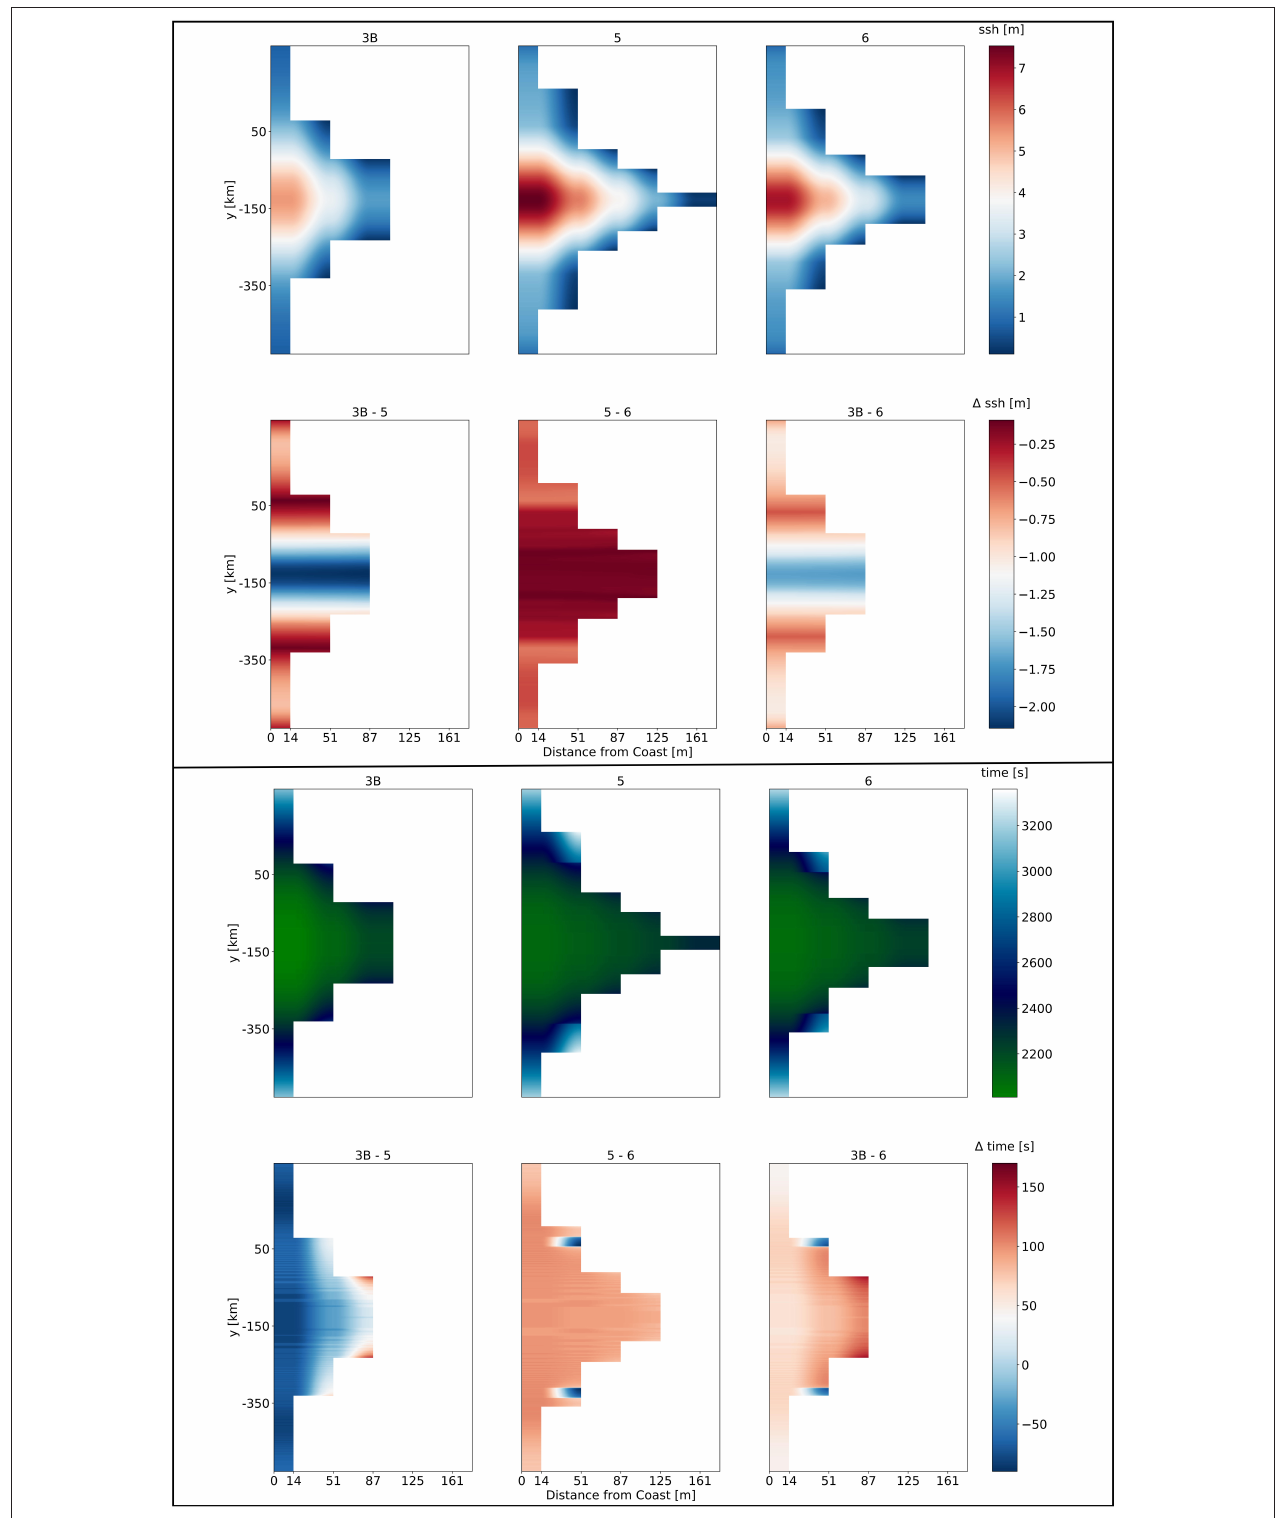
FIGURE 11 | (Top) Comparison of sea surface height for tsunami fronts arriving at the coast for the models 3B, 5, and 6. The difference between the models is shown as 1 ssh. In contrast to Figure 11 the x-axis (distance from coast) indicates higher values. This is due to the greater inundation area of model 5 which exceeds 161 m distance. (Bottom) Inundation comparison for models 3B, 5, and 6. The green to white color scale shows the time delay for the wave fronts arriving at the coast. The difference between the models is plotted as 1 t with a blue (negative values) to red (p color-scale, respectively.